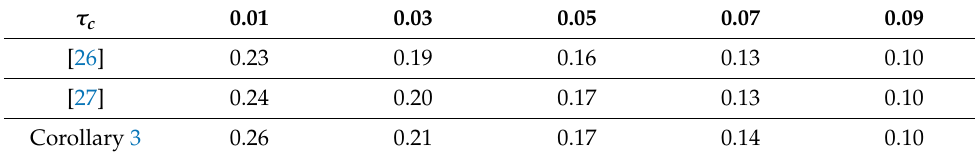
Table 3. The maximum sampling period d M for different τ c (Example 2).